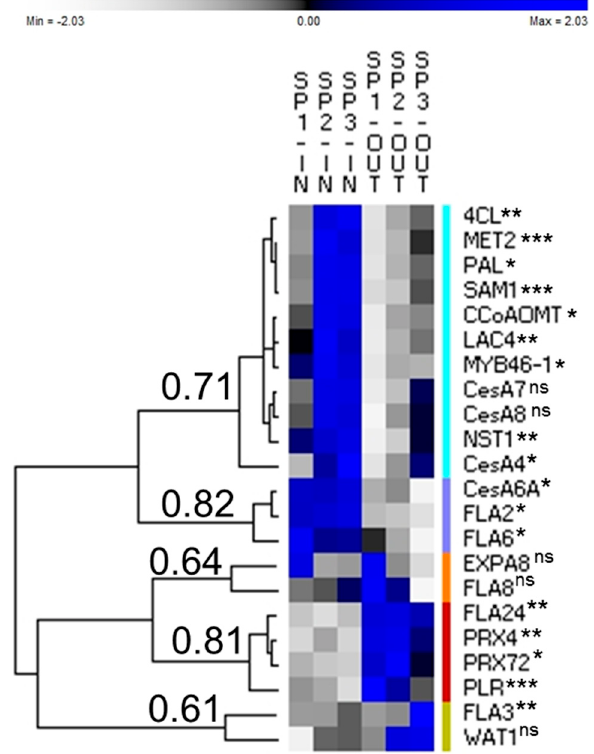
Figure 2. Normalised relative expression values of the six samples for each gene as calculated by qBASE + and PermutMatrix. N = 4. First cluster in turquoise; second cluster in violet; third cluster in orange; fourth cluster in red and fifth cluster in dark yellow. p -value < 0.05 *, 0.01 **, 0.001 *** and > 0.05 ns from ANOVA or Kruskall–Wallis test (Table S1). The Pearson correlation coefficient is indicated for each group. The normalised relative expression values and statistical tests are in Table S1. Abbreviations as in the text.